Question: Provide a one-line summary of what is displayed.
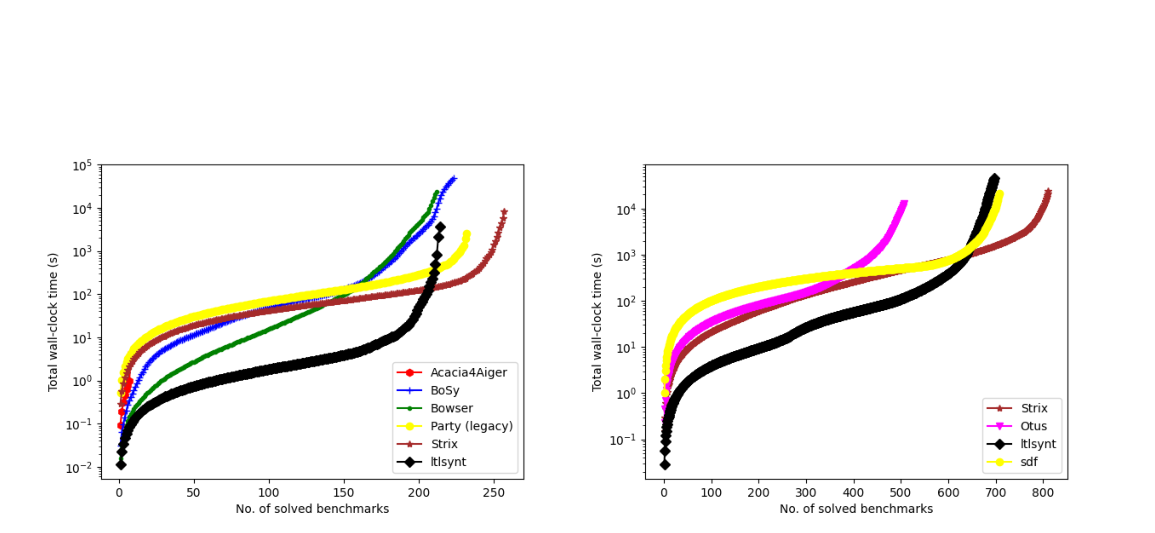
Answer: Cactus (a.k.a. survival) plots for the participants of the LTL synthesis track of SYNTCOMP 2018 (left) and 2021 (right); Again, the y-axis is displayed using logarithmic scale